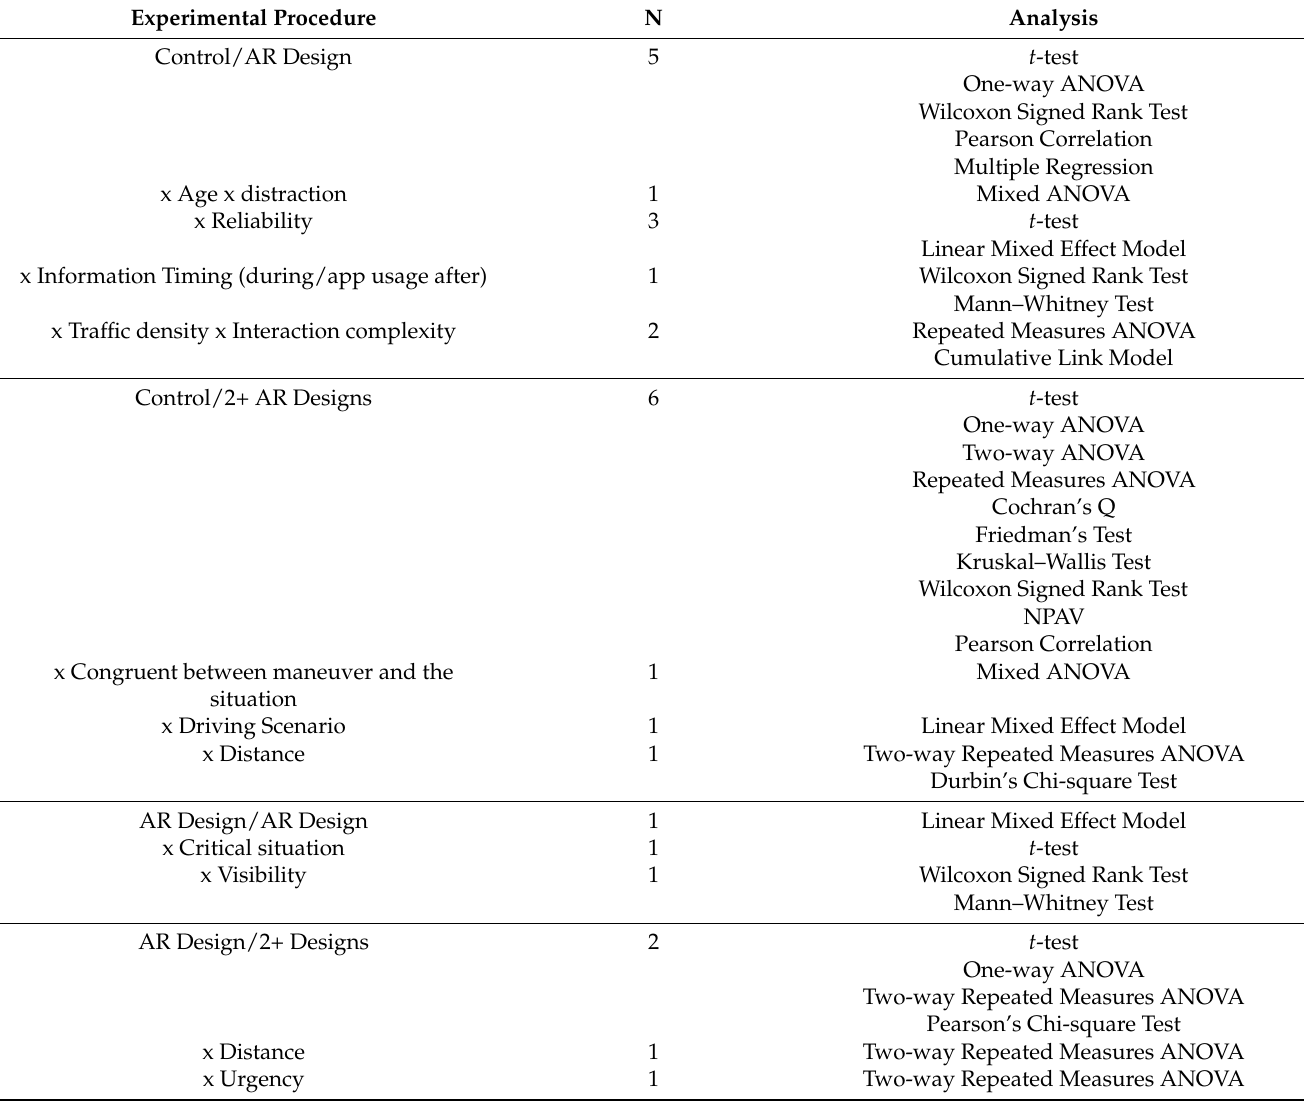
Table 4. Summary of the experimental designs across all articles and their corresponding